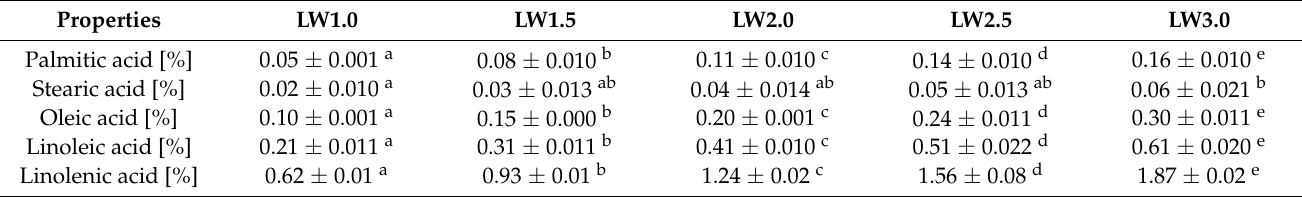
Table 4. Fatty acid content of ice cream with the addition of